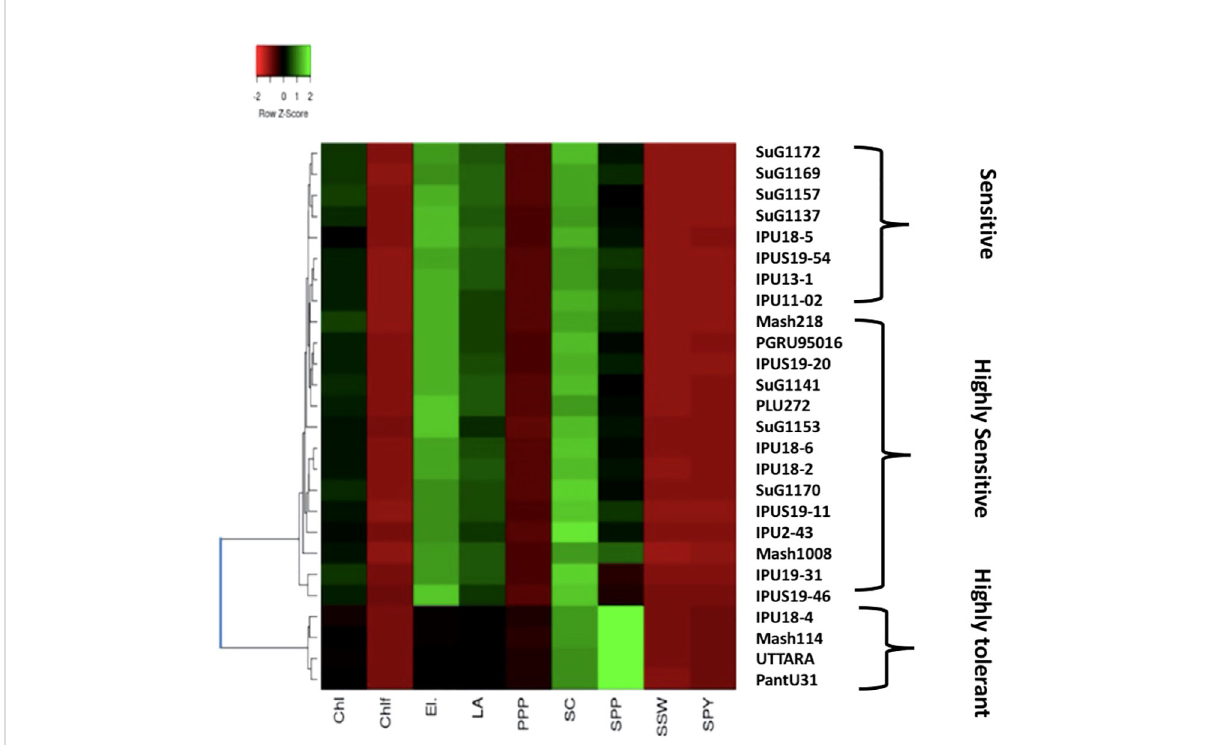
FIGURE 8 Heat map based on the response of urdbean genotypes to heat stress in the year